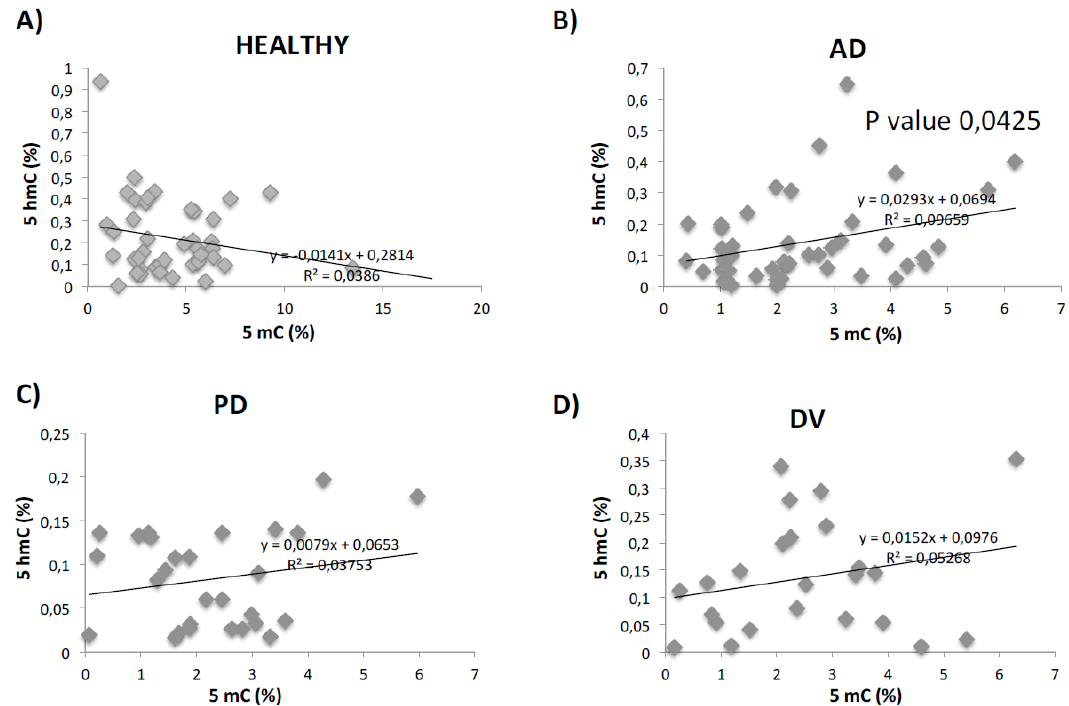
Figure 2. Correlation analysis between 5mC and 5hmC levels. Regression analysis of 5mC and 5hmC values in healthy ( A ), AD ( B ), PD ( C ) and DV ( D ) groups. p -values are also indicated in the graphics when this value is significant. p -value is indicated in the figures as * p < 0.05.